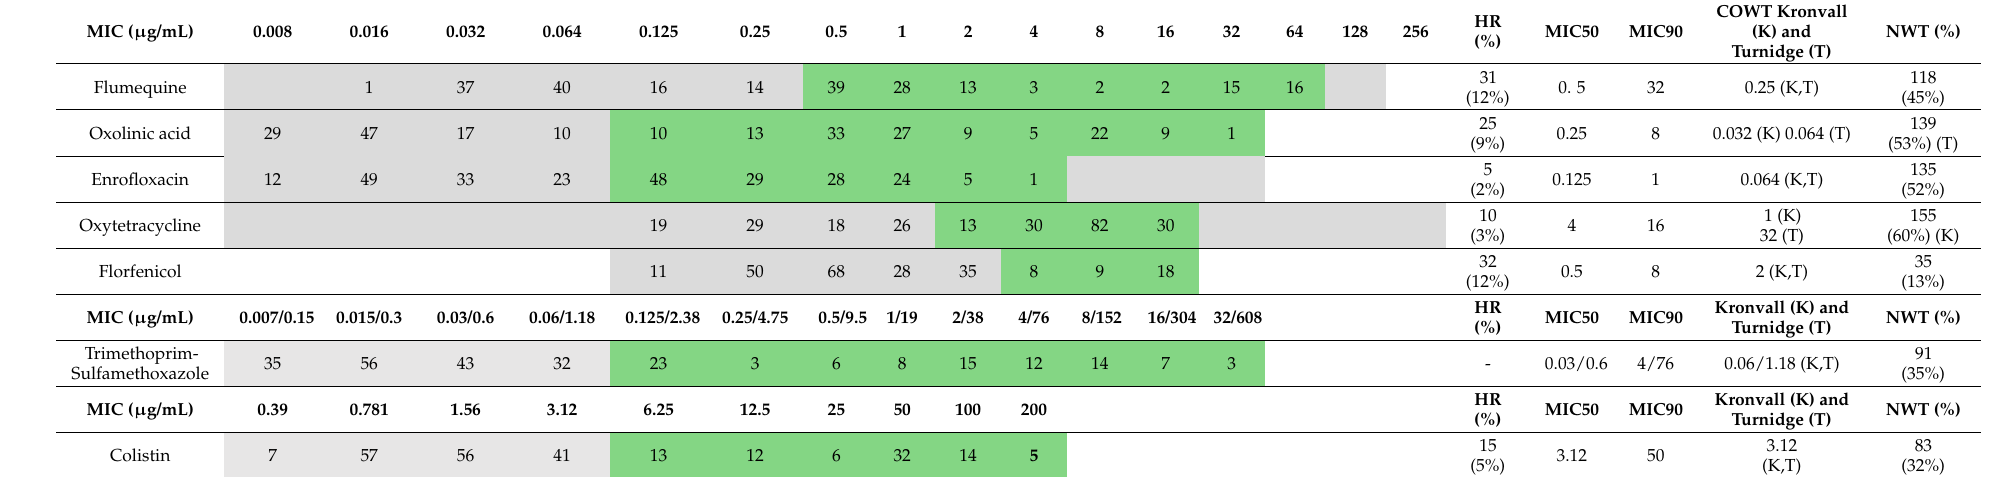
Table 2. Distribution of MIC values ( µ g/mL) in 257 isolates of Aeromonas